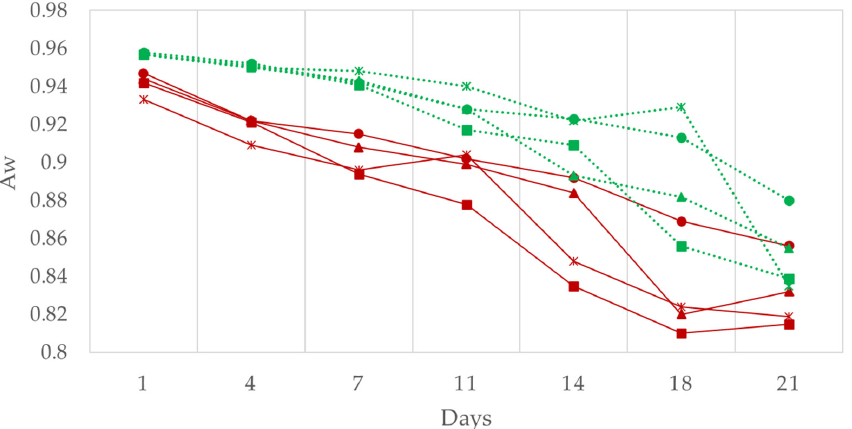
Figure 3. The effect of replacing pork backfat with high oleic sunflower oil on water activity in the traditional and reduced fat “Chorizo Zamorano” formulations during ripening. Traditional: ( ■ ) Control, ( ▲ ) 12.5%, ( ● ) 20%, and (×) 50% of backfat replacement. Reduced fat: ( ■ ) Control, ( ▲ ) 12.5%, ( ● ) 20%, and (×) 50% of backfat replacement.